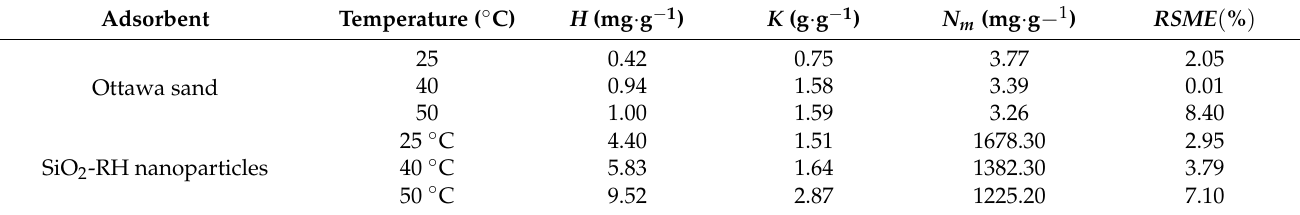
Table 4. Parameters of solid–liquid equilibrium (SLE) model for bio-fluid adsorption isotherms onto the sand rock and SiO 2 -RH